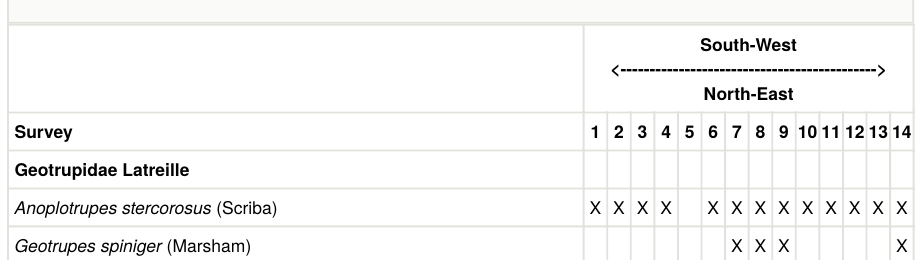
List of the species present in eleven valleys of the western Italian Alps. The di ff erent surveys have been kept separately. 1 = Valletta valley, 2008; 2 = Lourousa valley, 2008; 3 = Troncea B valley, 2011; 4 = Troncea valley, 2011-2012; 5 = Argentera valley, 2010; 6 = Grande valley, 2010; 7 = Champorcher valley, 2005-2006; 8 = Chalamy valley, 2005-2006; 9 = Chalamy valley, 2007; 10 = Gressoney valley, 2010; 11 = Ferret valley, 2005-2006; 12 = Ferret valley, 2007; 13 = Veny valley, 2005-2006; 14 = Sessera valley,